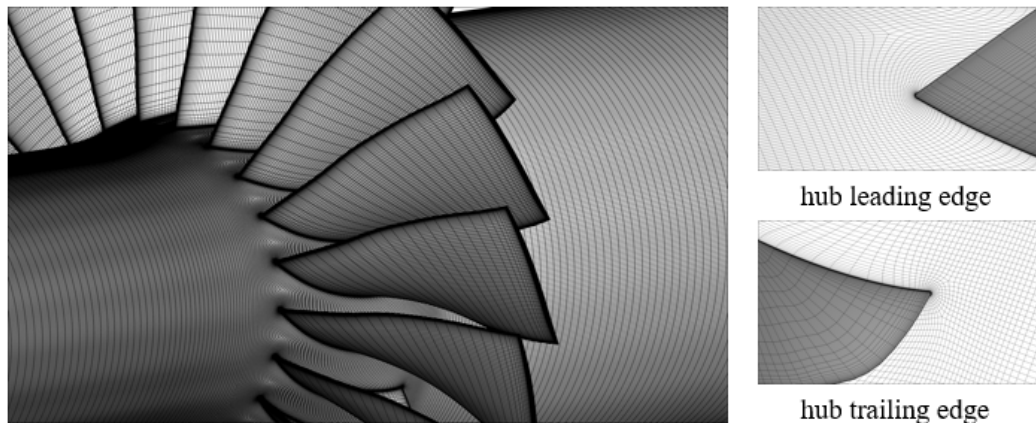
Figure 3. Sketch of Grid 3.